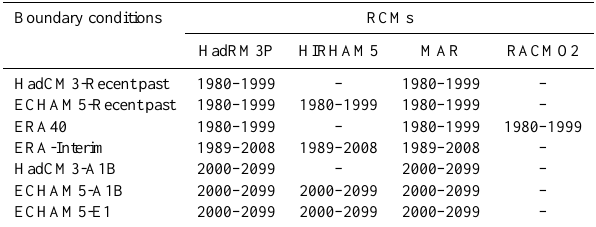
Table 1. Summary of RCM simulations performed. Boundary